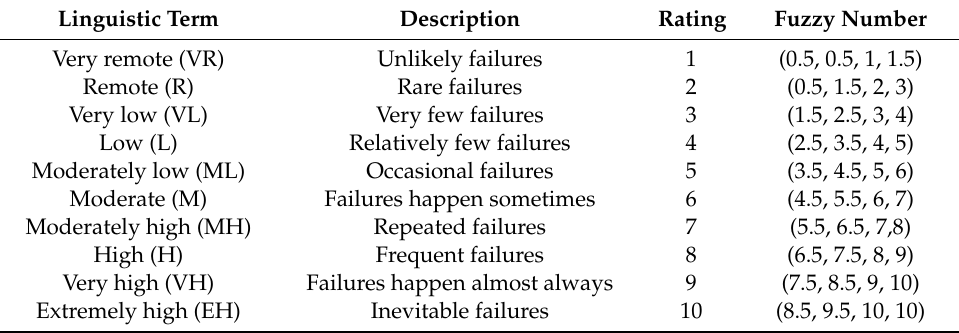
Table 2. Fuzzy evaluation criteria of